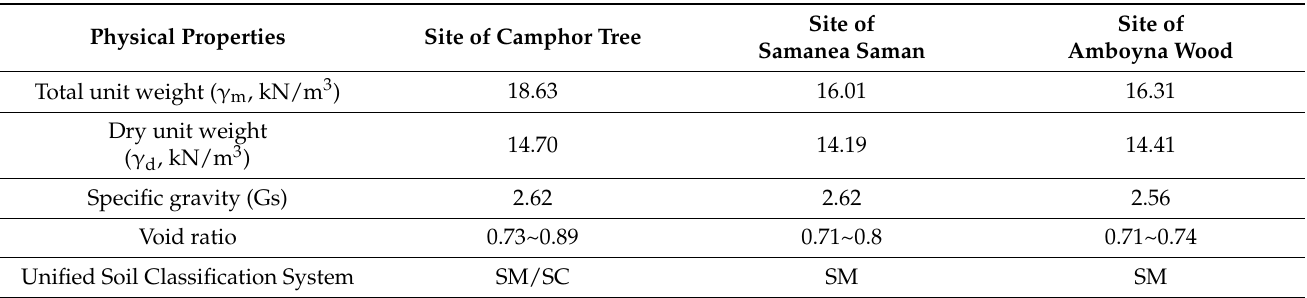
Table 1. Soil properties at the experimental